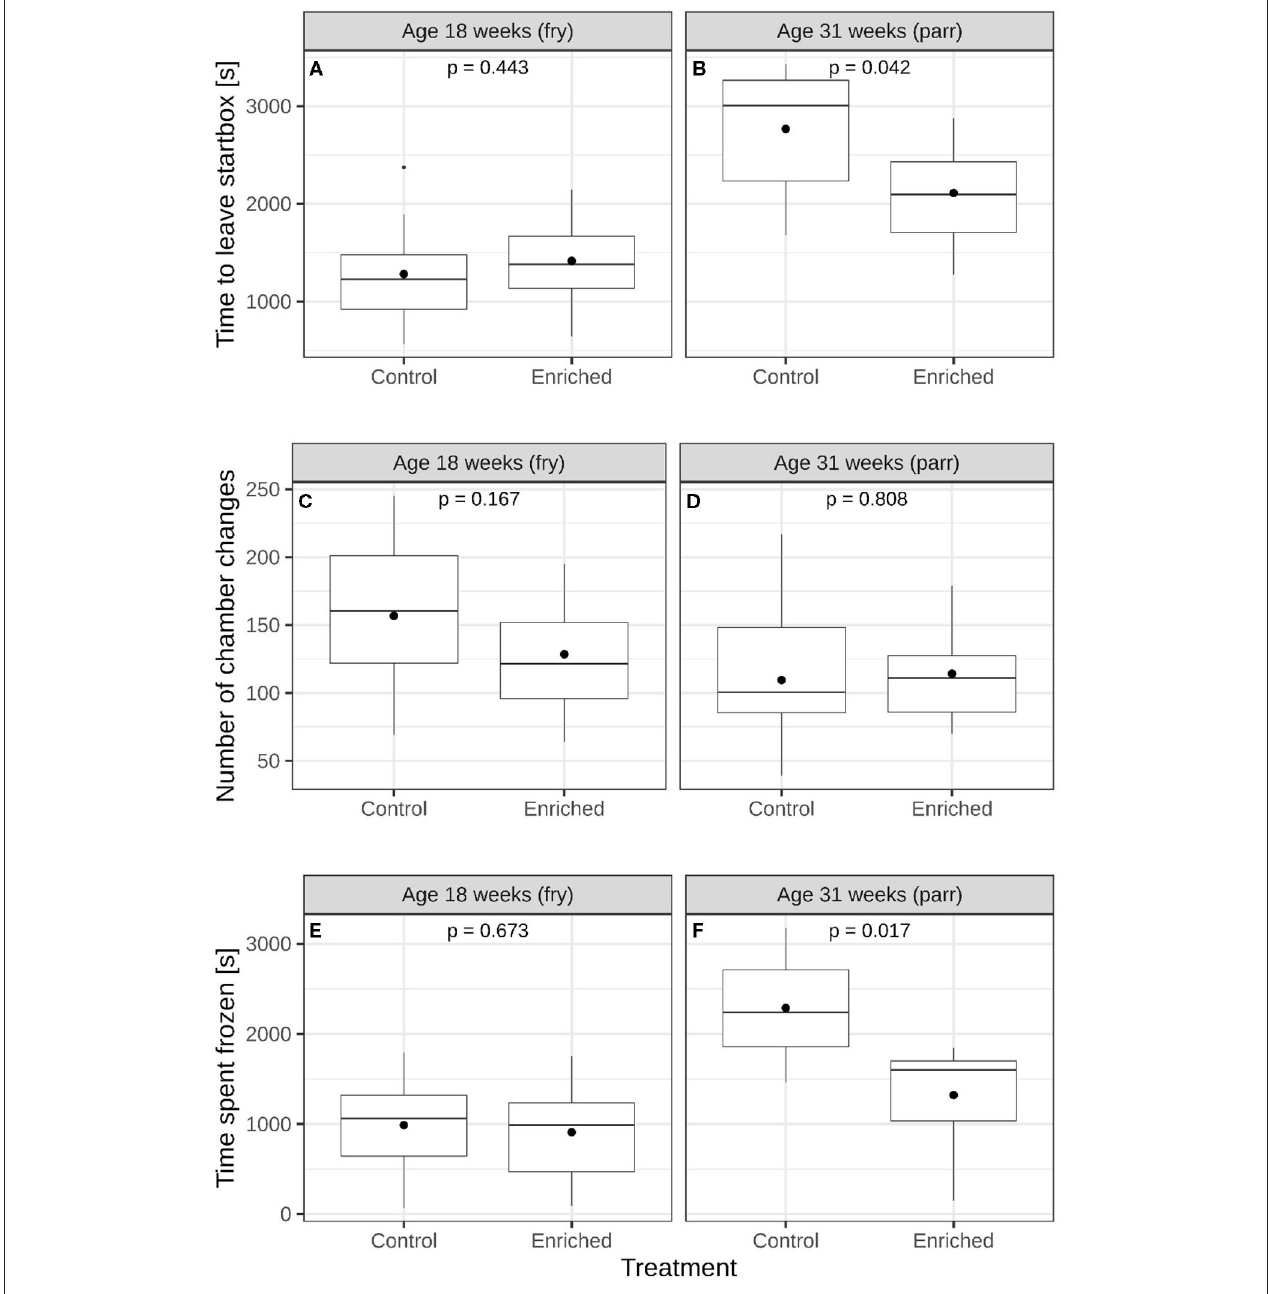
FIGURE 2 | Comparisons of enriched reared and control reared juvenile Atlantic salmon ( Salmo salar ). Time to leave start box of (A) 18-week-old and (B) 31-week-old juveniles. Number of chamber changes of (C) 18-week-old and (D) 31-week-old juveniles. Time spent freezing of (E) 18-week-old and (F) 31-week-old juvenile salmon. The boxes show the medians and quartiles while the whiskers show the extremes within 1.5 times the interquartile range. Black circles represent mean values. The p -values in each panel represent a comparison of mean values between the two groups.